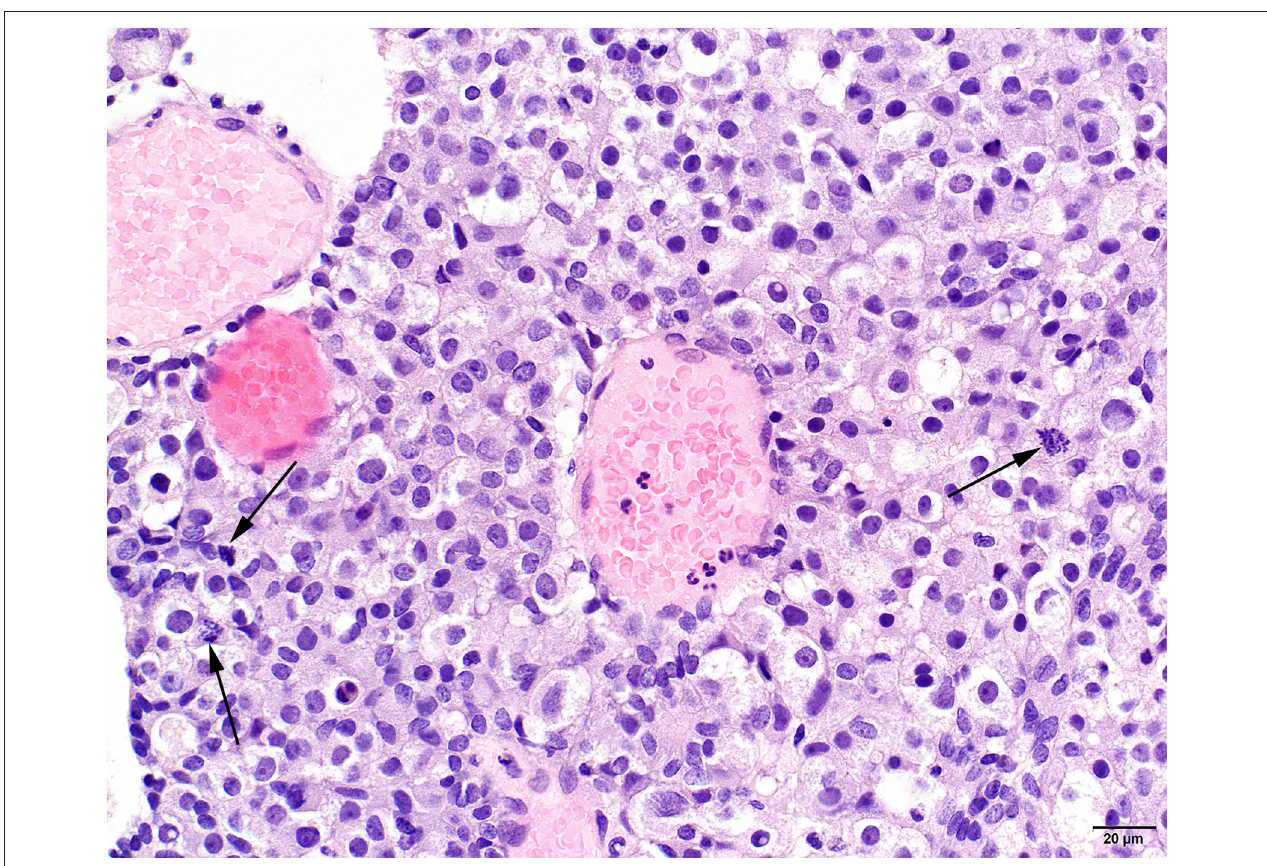
FIGURE 3 | Histological view of surgical specimen of the pituitary tumor tissue 5 months after holmium-166 microsphere treatment. Basophilic neoplastic cells in sheets with pronounced variation in nuclear size and several mitotic figures (arrows). HE stains, obj. 40x.